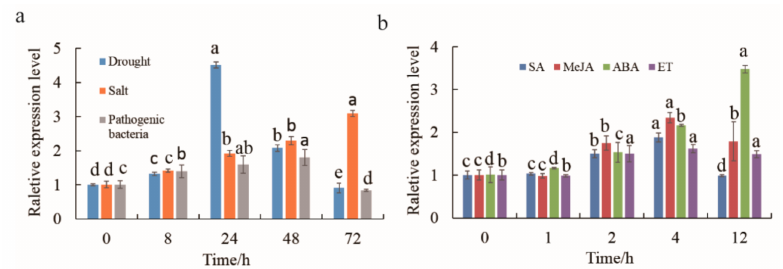
Figure 4. Analysis of MnMYB3R1 transcription in M. notabilis . ( a ) Transcription levels of MnMYB3R1 in mulberry leaves after drought, salt, and gray mold treatments; ( b ) transcription levels of MnMYB3R1 in mulberry leaves after hormone treatments. The M. notabilis seedlings grown under the same conditions were subjected to drought, or salt stress conditions or were infected with gray mold for 0, 8, 24, 48, and 72 h. Regarding the hormone treatments, the M. notabilis seedlings grown under the same conditions were treated with ABA, SA, ET, or MeJA for 0, 1, 2, 4, and 12 h. Leaves collected from the treated seedlings were frozen in liquid nitrogen and stored at − 80 ◦ C for a subsequent total RNA extraction. The corresponding tissues of untreated seedlings served as controls. Relative transcript levels were determined by qPCR. Data are presented as the mean ± SD ( n = 3).